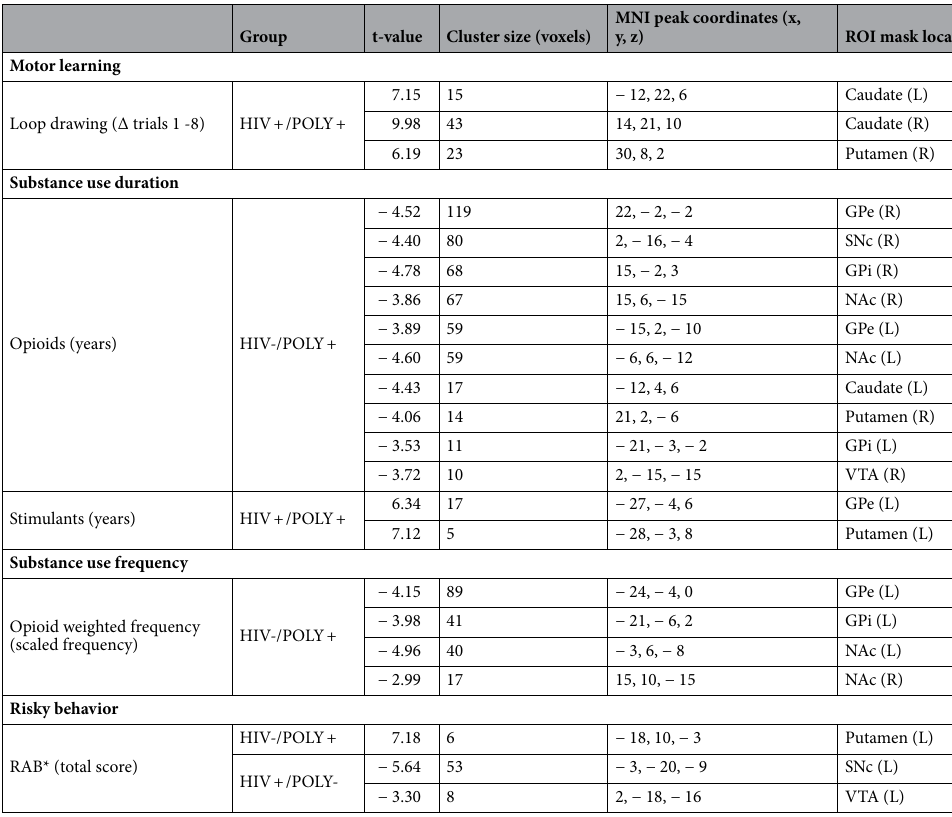
Table 4. Regressions between regional basal ganglia gray matter volume, motor learning, pattern of substance use, and risky behavior. Results met criteria for p < 0.05 FWE with a cut-off threshold of ≥ 5 voxels. Negative t-values represent negative associations. L = left; R = right.